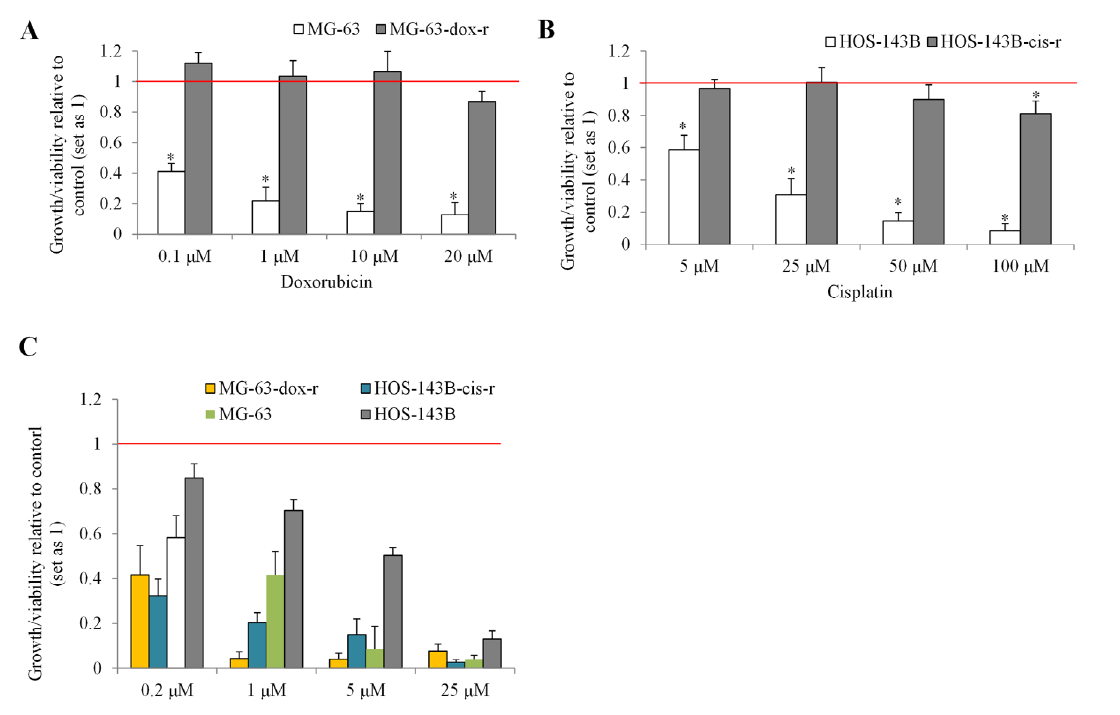
Figure 2 – Niclosamide is preferentially active against chemo-resistant osteosarcoma cells . (A) The growth/viability of MG-63 and MG-63-dox-r cells in the presence of doxorubicin. (B) The growth/viability of HOS-143B and HOS-143B-cis-r cells in the presence of cisplatin. After 3 days treatment, cell growth/viability was measured using CellTiter® 96 Aqueous One Solution cell proliferation assay. (C) Niclosamide at 0.2, 1, 5 and 25 µM dose- dependently decreases growth/viability in MG-63, HOS-143B, MG-63-dox-r and HOS-143B-cis-r cells. *, p<0.5, compared to control. Control was set up as 1. Unpaired Student’s t test was